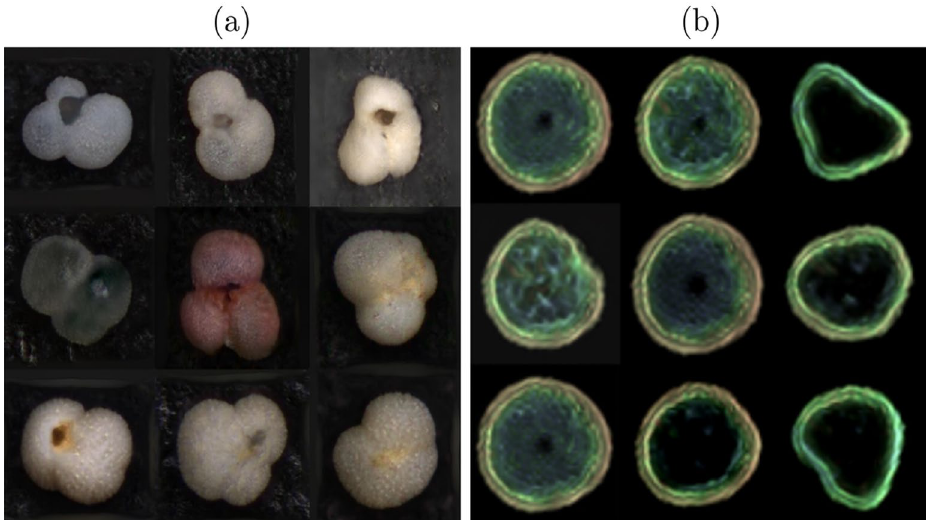
Figure 12. Transferability of the technique to other geological datasets ( a ) Foraminifera Species, ( b ) Pollen